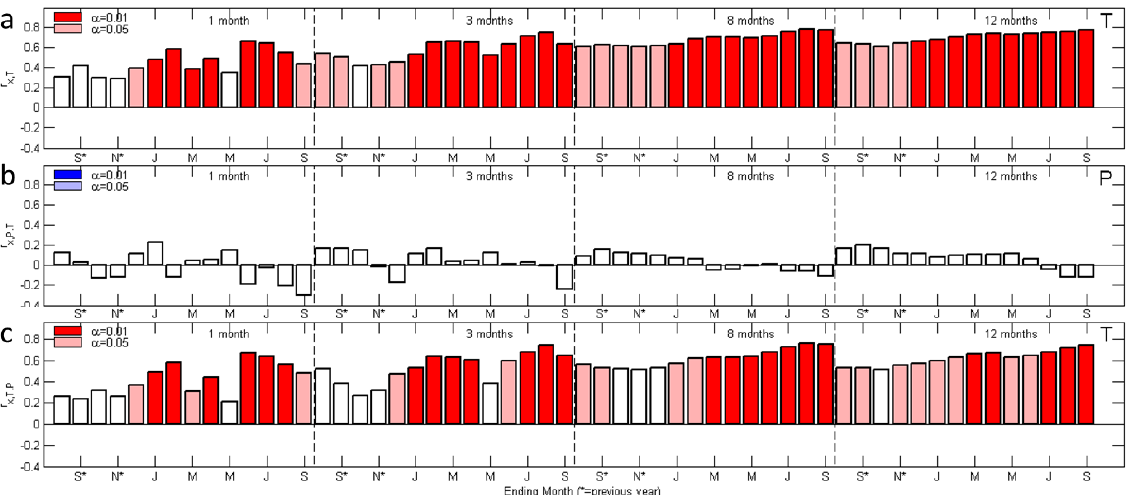
Figure 5. Correlations and partial correlations between the tree-ring series and the multi-month averages of climatic variables from Yeniugou and Zhangye. (a) Simple correlations with the primary climatic variable, the mean minimum temperature anomalies of the two stations (Zhangye and Yeniugou). (b) Partial correlations between the tree-ring index and the secondary climatic variable, the mean precipitation anomalies of the two stations, when the minimum temperature was the control variable. (c) Partial correlations between the tree-ring index and the secondary climatic variable, the mean minimum temperature anomalies of the two stations, when the mean precipitation anomalies was the control variable. The x axis presents months from August of the previous year to September of the current year.